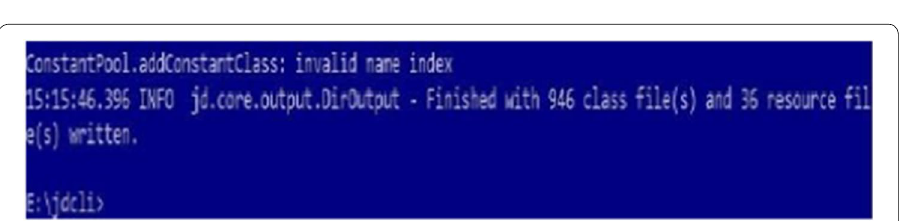
Fig. 6 Java files extracted to E:\work1